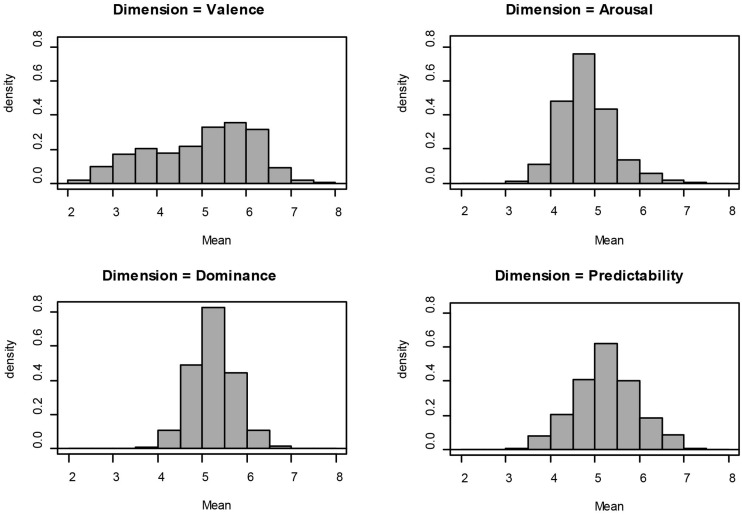
Distribution of emotional dimension ratings.